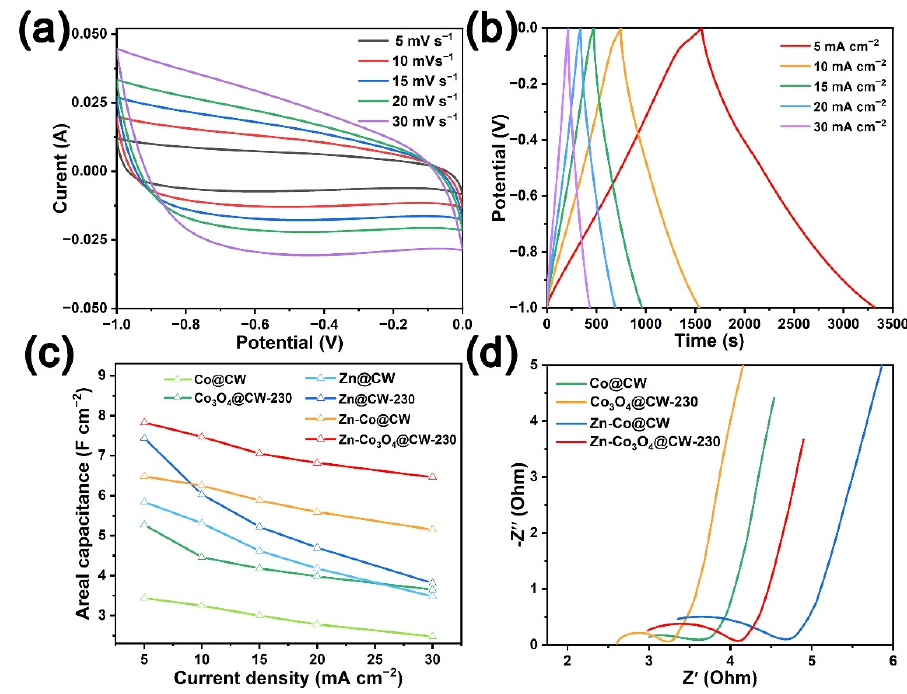
Figure 4. Cyclic voltammograms (CVs) at different scan rates and galvanostatic charge-discharge (GCD) curves at different current densities of ( a , b ) Zn-Co 3 O 4 @CW-230. ( c ) Specific capacitances of Zn/Co/Zn-Co@CW and Zn/Co 3 O 4 /Zn-Co 3 O 4 @CW-230 at different current densities. ( d ) the EIS plots of the Co/Zn-Co@CW and Co 3 O 4 /Zn-Co 3 O 4 @CW-230. To investigate the application potential of CW-230, Co 3 O 4 @CW-230, and Zn- Co 3 O 4 @CW-230 electrodes in liquid-state SCs, we assembled CW-230//CW-230,